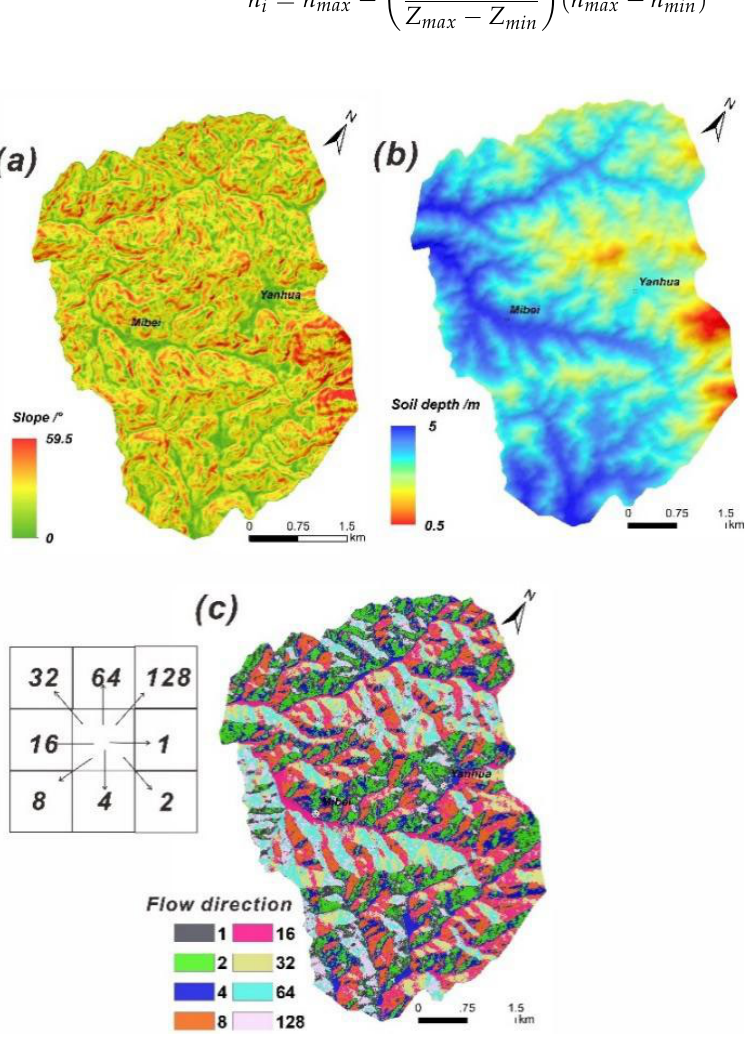
Figure 17. Maps showing the distribution of slope angle ( a ), soil thickness ( b ) and flow direction ( c ). Table 1. Mechanical properties of the